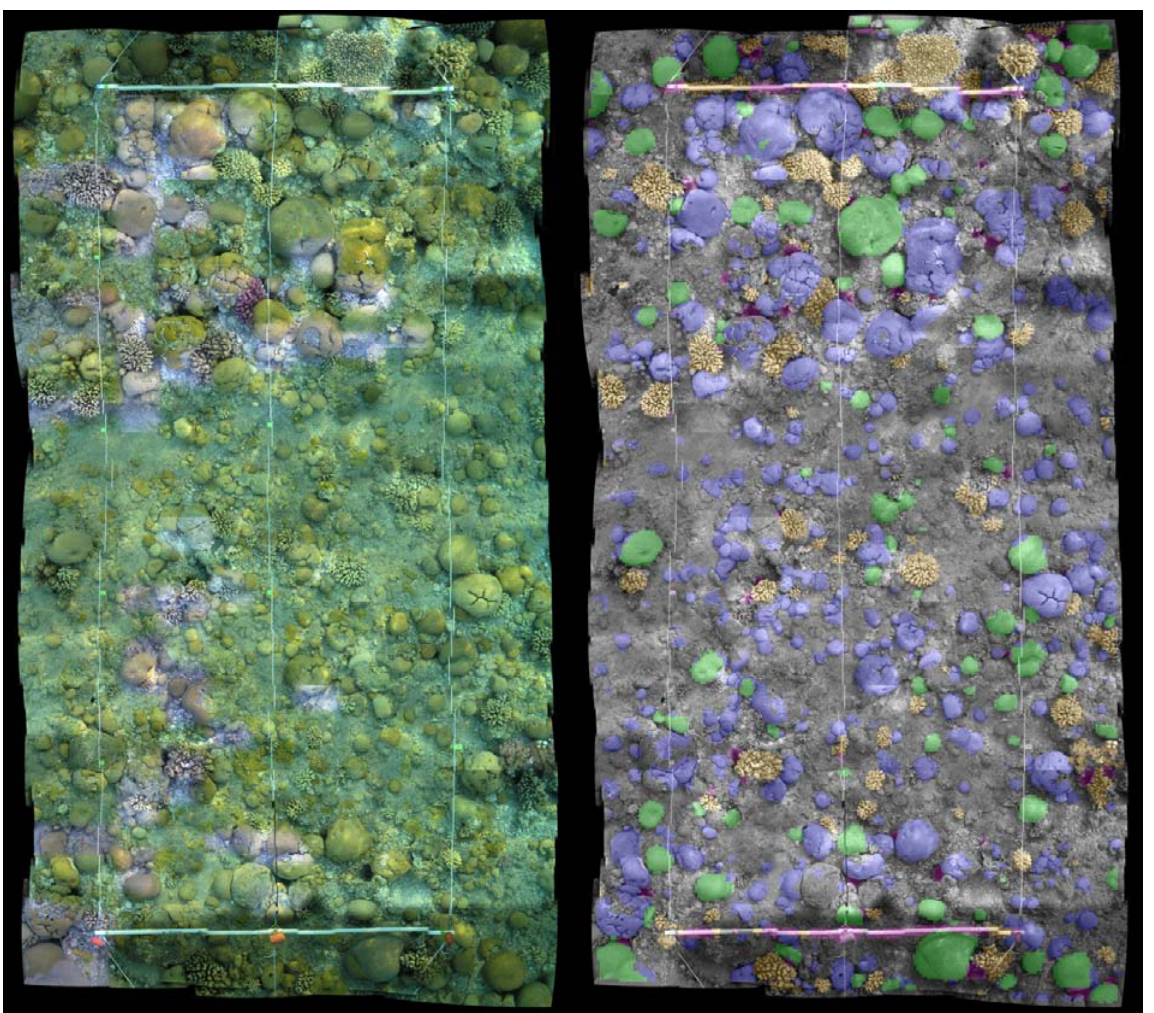
Figure 9. The original ( left ) and classified Red Sea mosaic ( right ). The segmented images are color coded with the same classification scheme as Figure